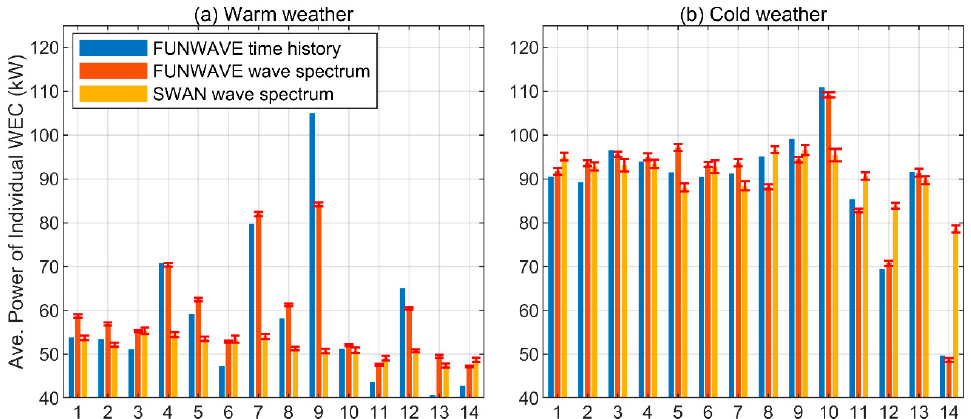
Figure 11. Average power of individual devices in the WEC farm under ( a ) warm and ( b ) cold weather conditions. The column bars are colored by the type of input used in the WEC-Sim simulations. The red error bars indicate the 95% CIs.